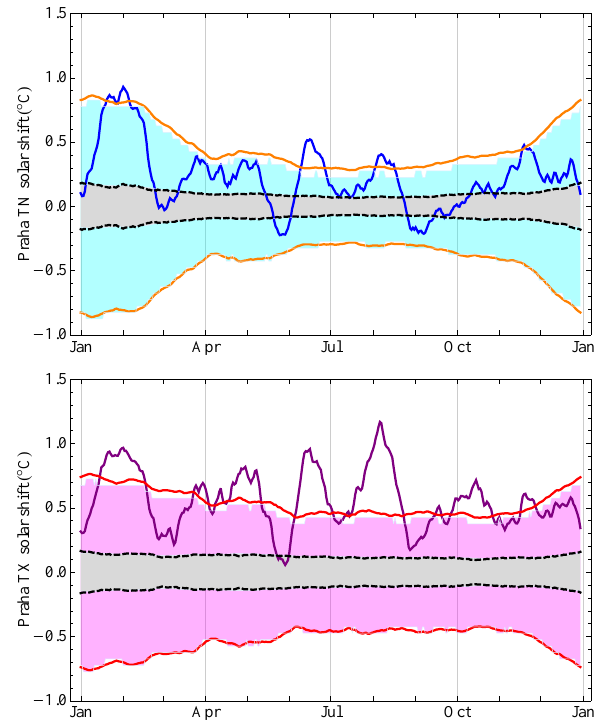
Fig. 5. Upper panel: Blue: Solar shift for the minimum (TN) tem- perature in Praha. Orange: bounds of the 90% confidence interval ± aσ S . Dashed black: ± standard deviation of the solar shift for the decorrelated dataset. Grey area: confidence interval according to LMKC. Cyan area: 90% confidence interval according to random perturbation test. Lower panel: Purple: Solar shift for the maximum (TX) temperature in Praha. Red: bounds of the 90% confidence in- terval ± aσ S i . Dashed black: ± standard deviation of the solar shift for the decorrelated dataset. Grey area: confidence interval accord- ing to LMKC. Magenta area: 90% confidence interval according to random perturbation test.